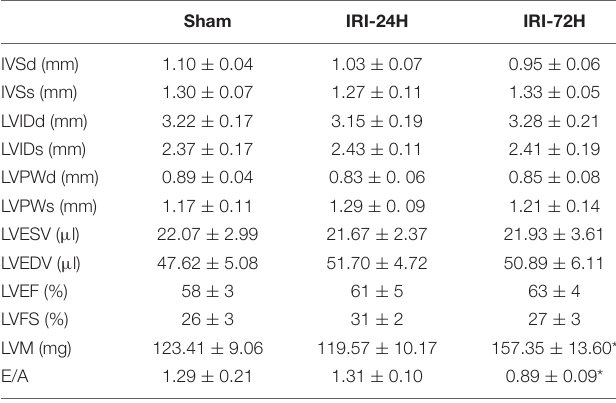
TABLE 1 | Echocardiography after renal ischemia–reperfusion injury.